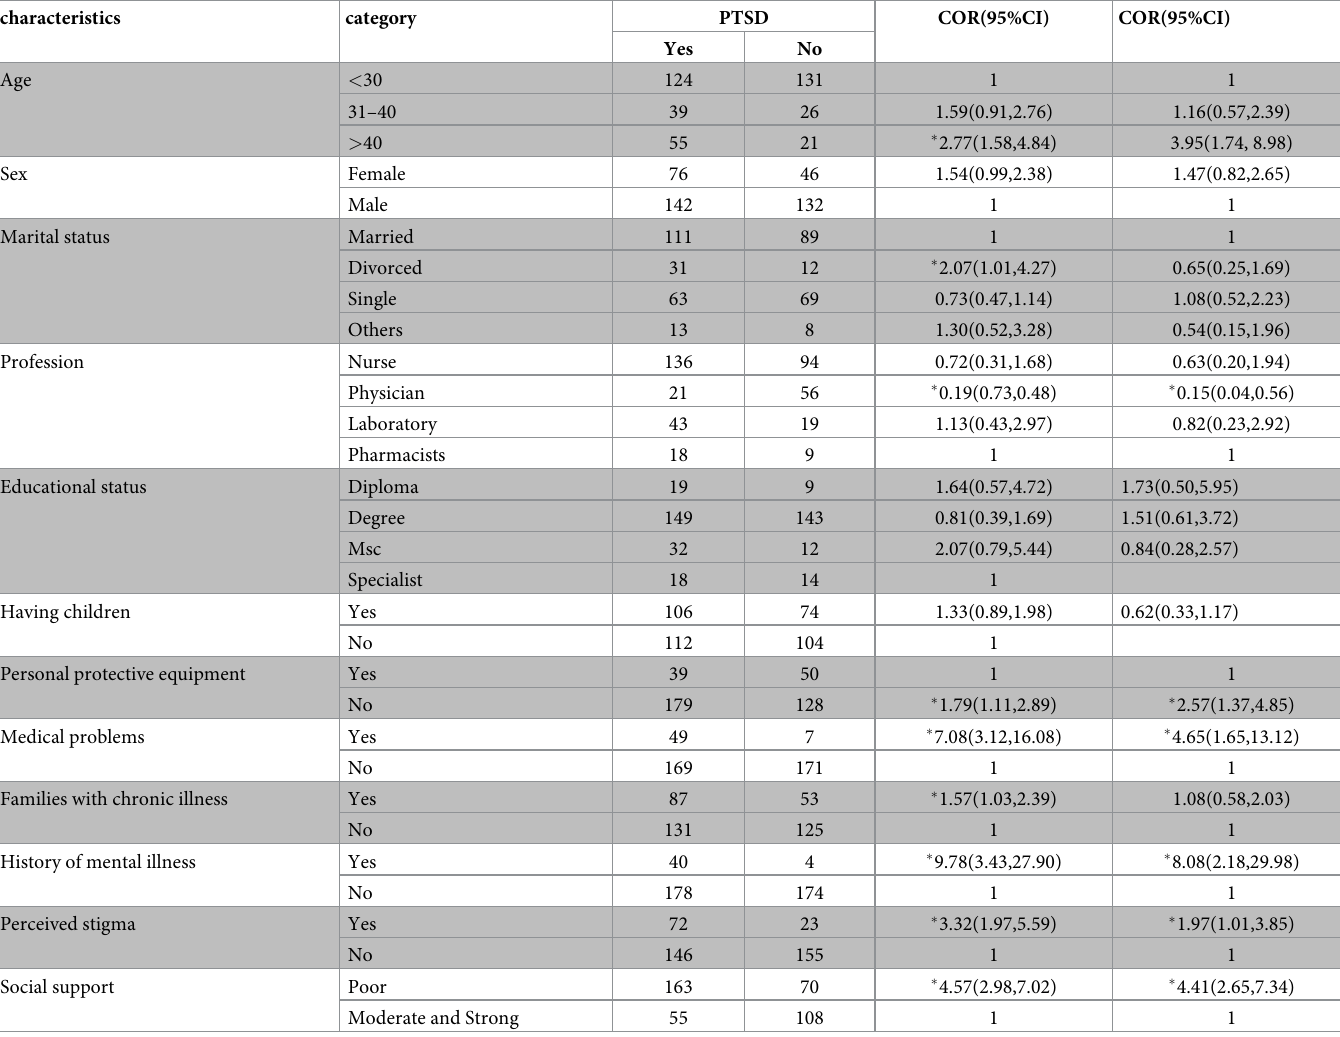
Table 4. Multivariable analysis showing factors associated with PTSD on health care providers in South Gondar hospitals, Ethiopia, 2020. characteristics